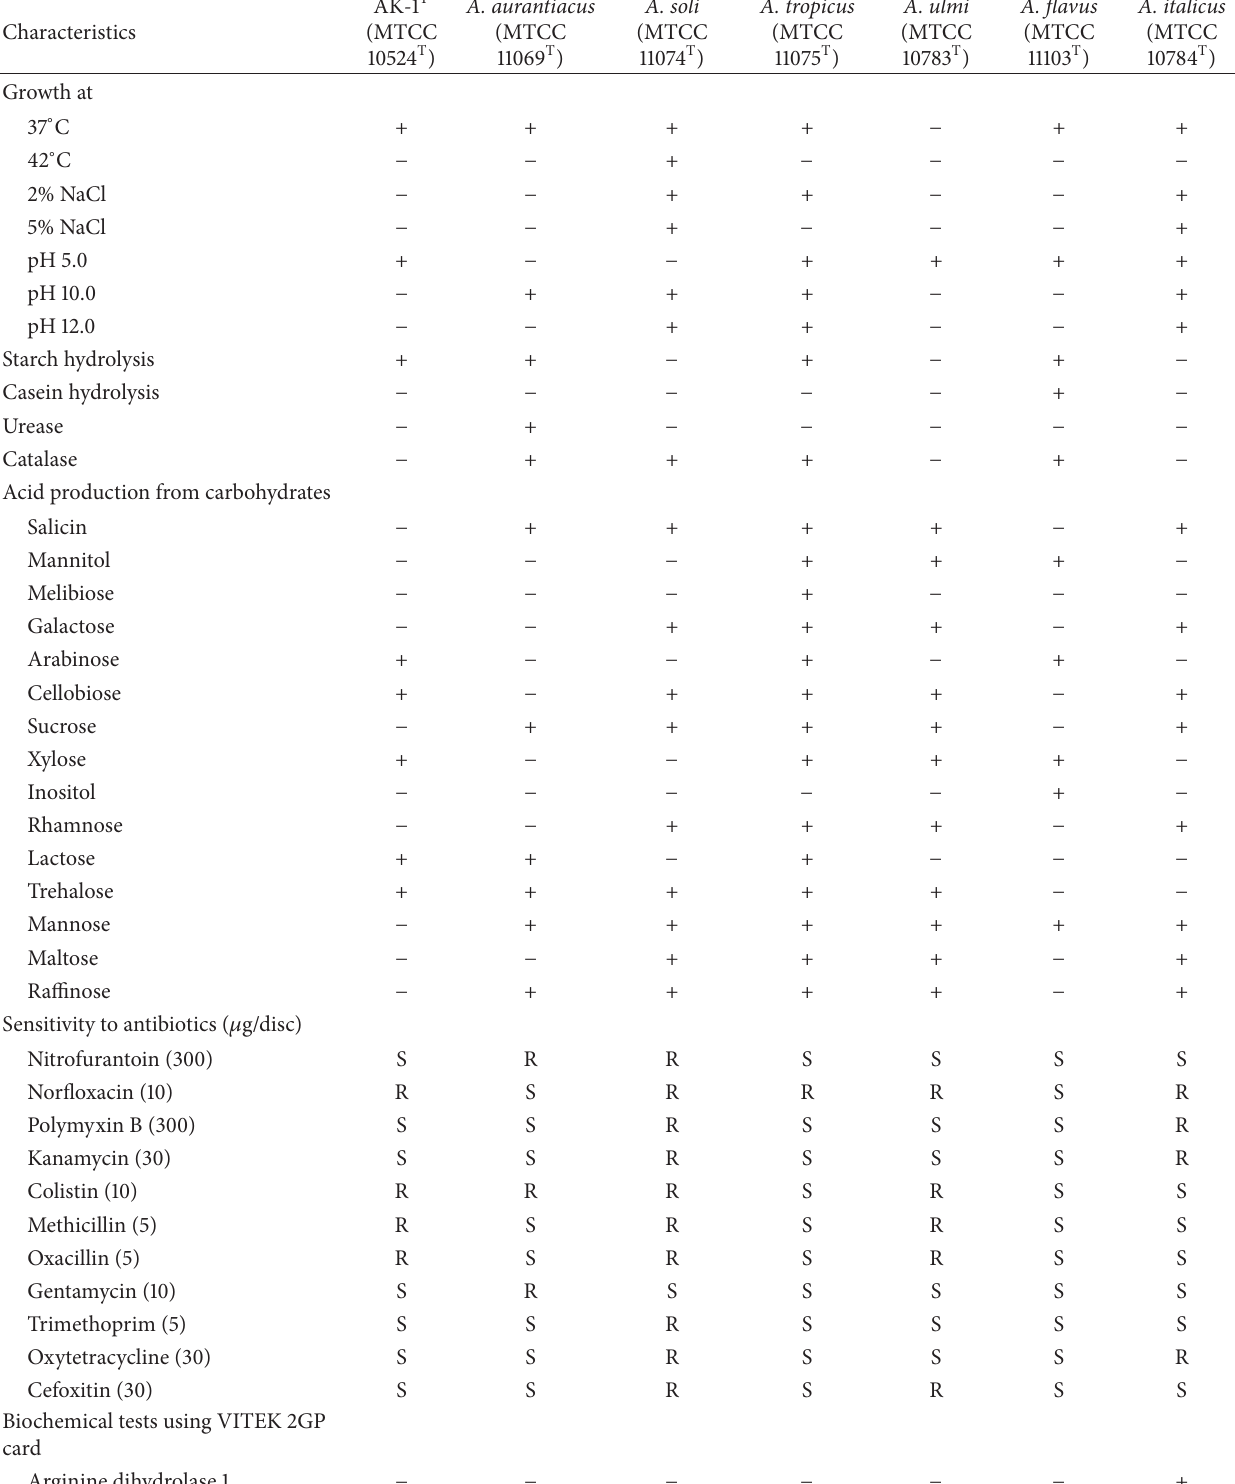
Table 1: Differential characteristics that differentiate strain AK-1 T along with the closest species AK-1 T (MTCC 10524 T ), A.